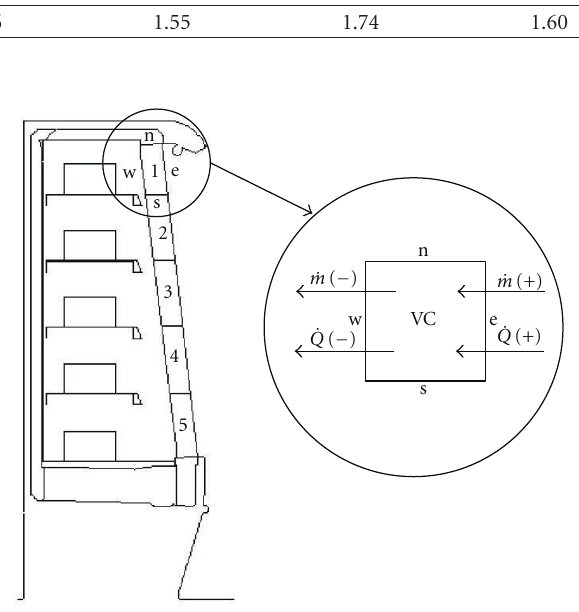
Table 4: DAG velocity prediction values for the di ff erent cases—OPTv case study. Variable